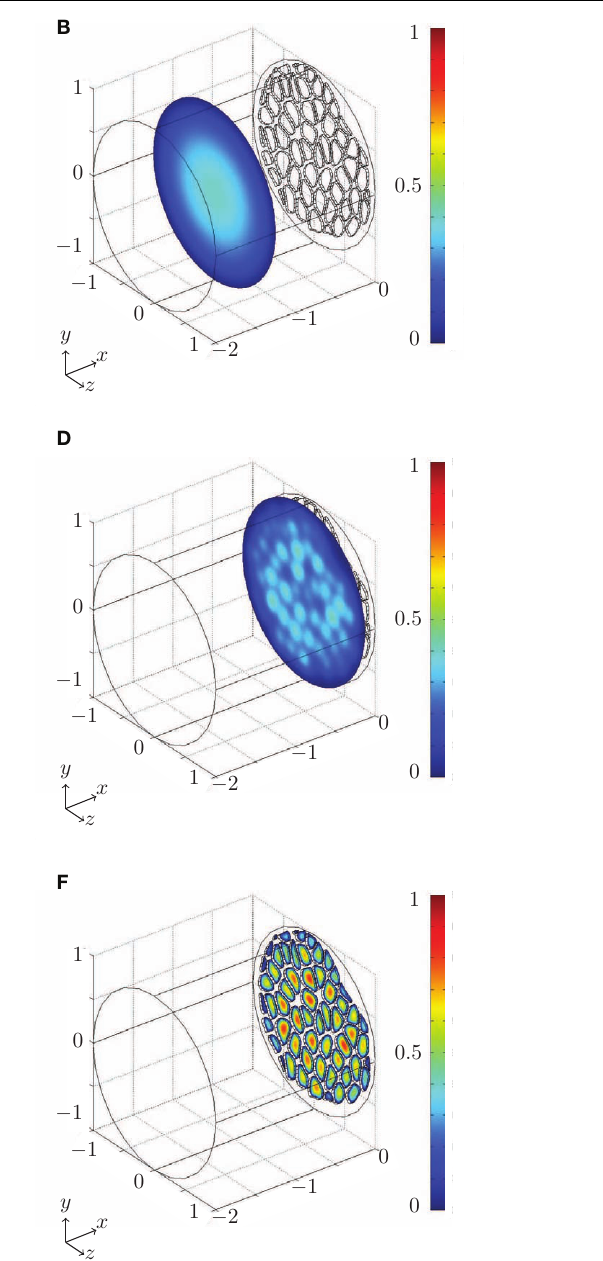
are taken is x =− 2, − 1.25, − 0.36, − 0.13, − 0.07, 0.025.The flow profile in (A,B) is the familiar parabolic profile found in conventional pipe flows. (C–E) The flow is distorted progressingly more for diminishing distance to the sieve plate where (F) the fluid passes through the pores. See Movie S1 in Supplementary Materials and Appendix B for further